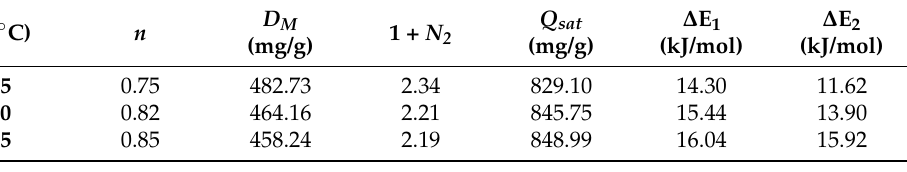
Table 5. Steric and energetic parameters of the advanced multilayer model for MB uptake by the BE/SD–MNPs composite.